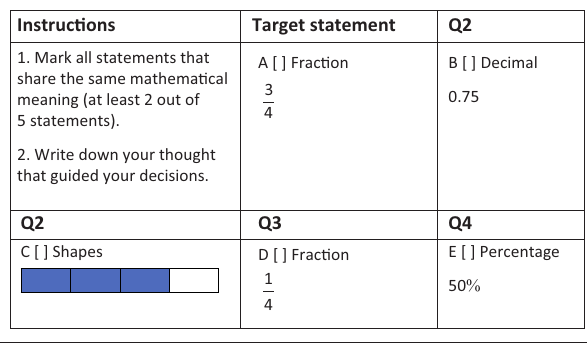
FIGURE 1: Example of MERLO assessment items, on